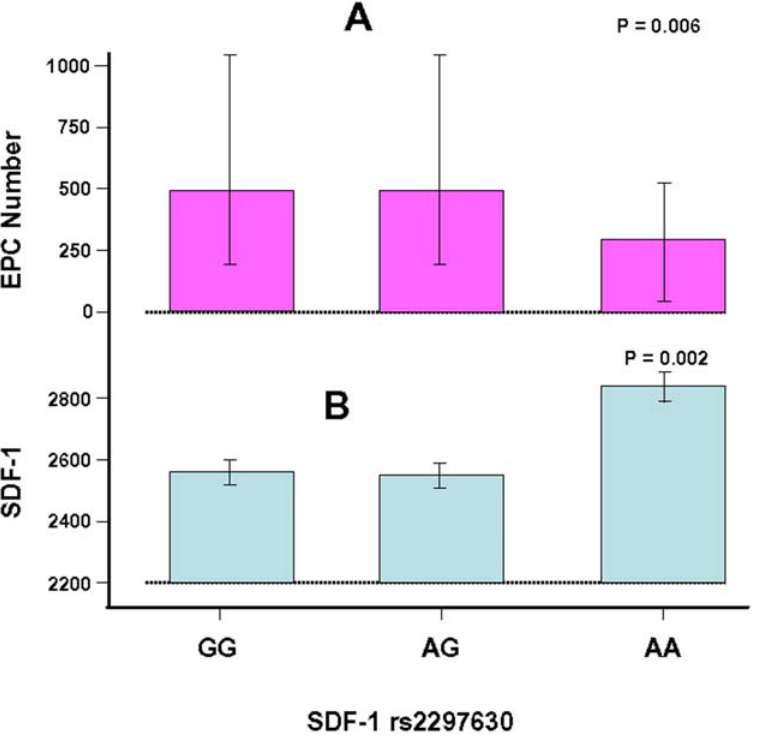
Figure 2. Associations of the SDF1 rs2297630 SNP (2000) with EPC number (median and IQR, A) and blood SDF1 a level (arithmetic means and SD, B) assessed in the 2005 evaluation of the Bruneck Study.